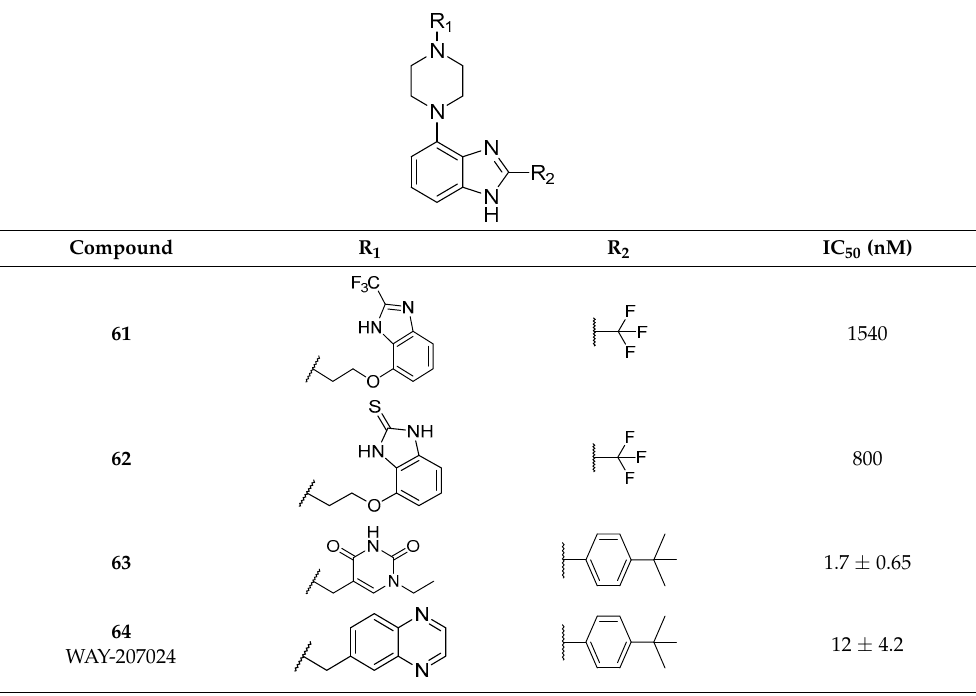
Table 11. Piperazine-benzimidazole derivatives and their binding affinity at human GnRH-R.